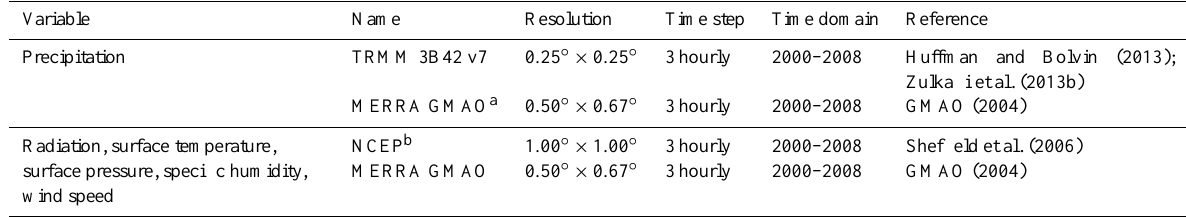
Table 2. Meteorological data used to drive the models.